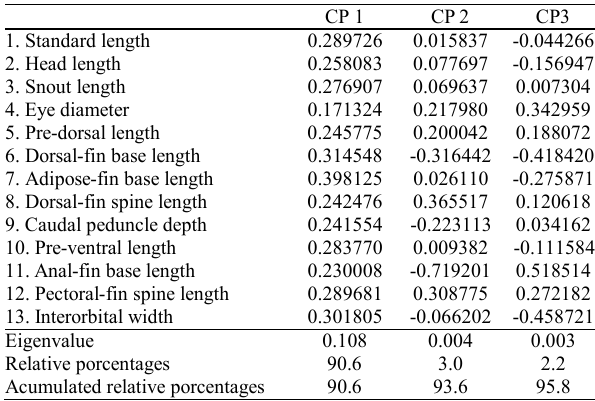
Table 1. Weight of variables, eigenvalues and percentages relating to the first, second, and third eigenvectors of the Principal Components obtained from the analysis of combined samples of Pimelodella species.